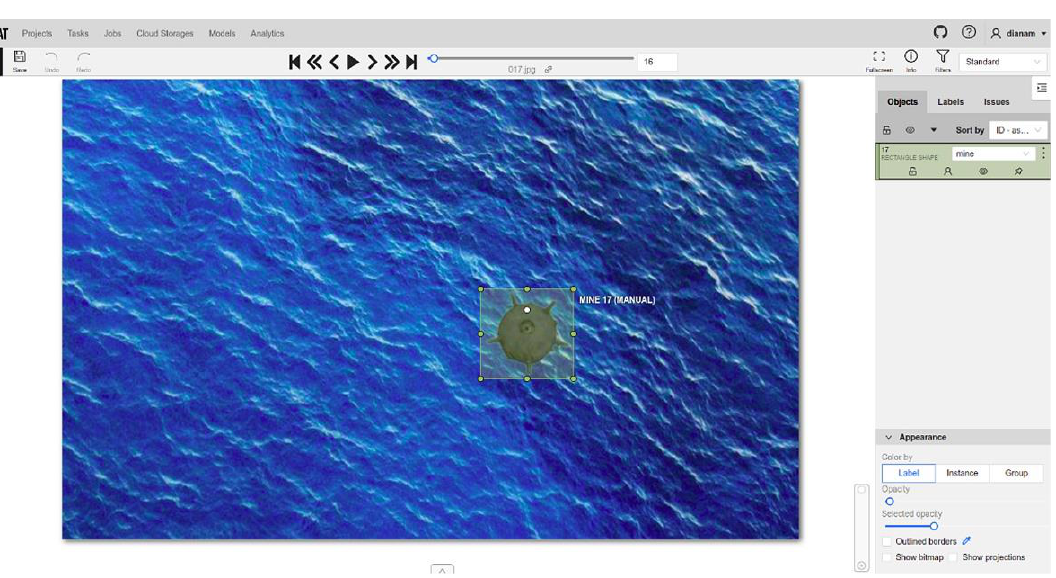
Figure 8. Synthetic images with floating mines.